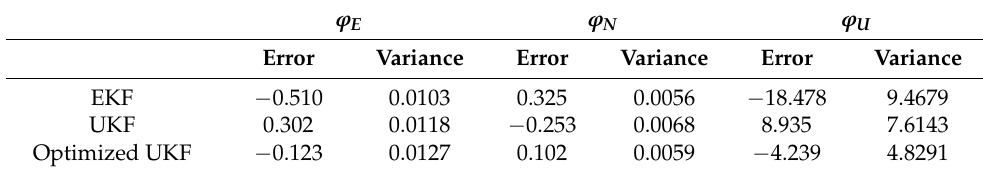
Table 1. Filtering Results of error angle.